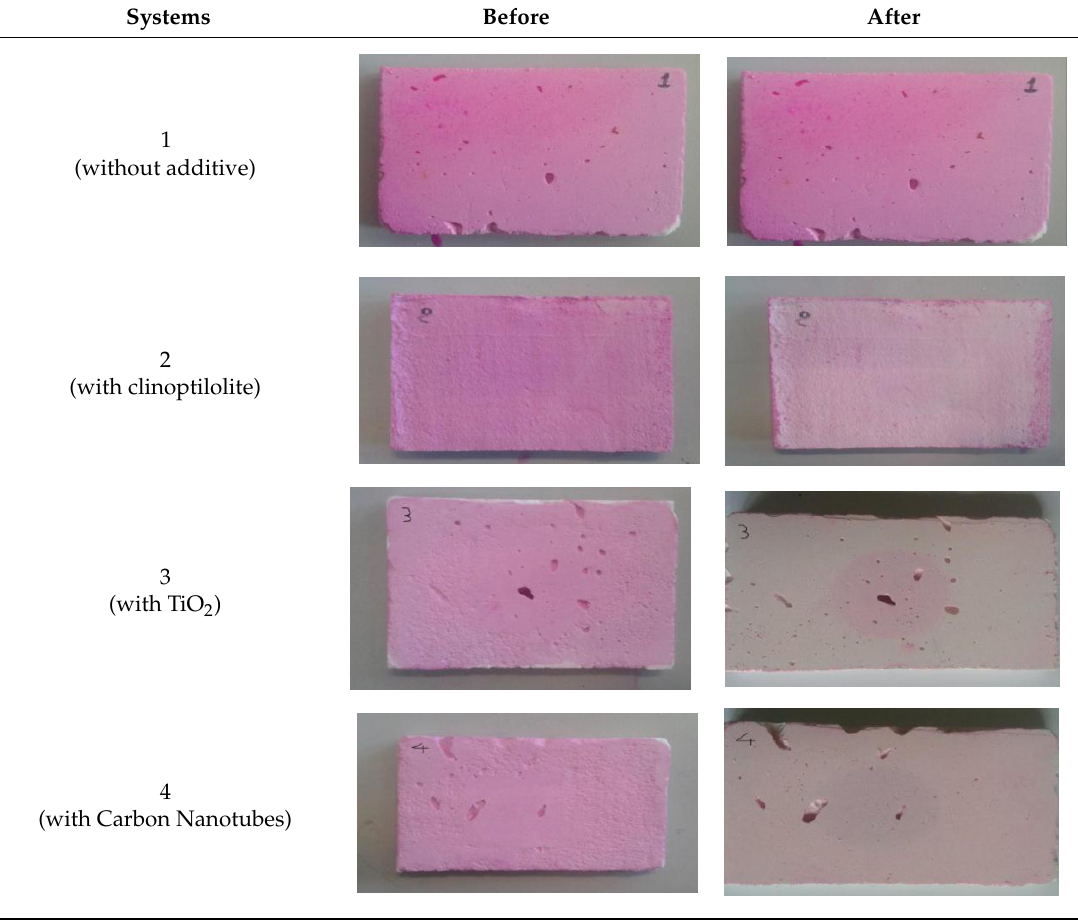
Table 2. Images of specimens before and after UV irradiation for 3 h.